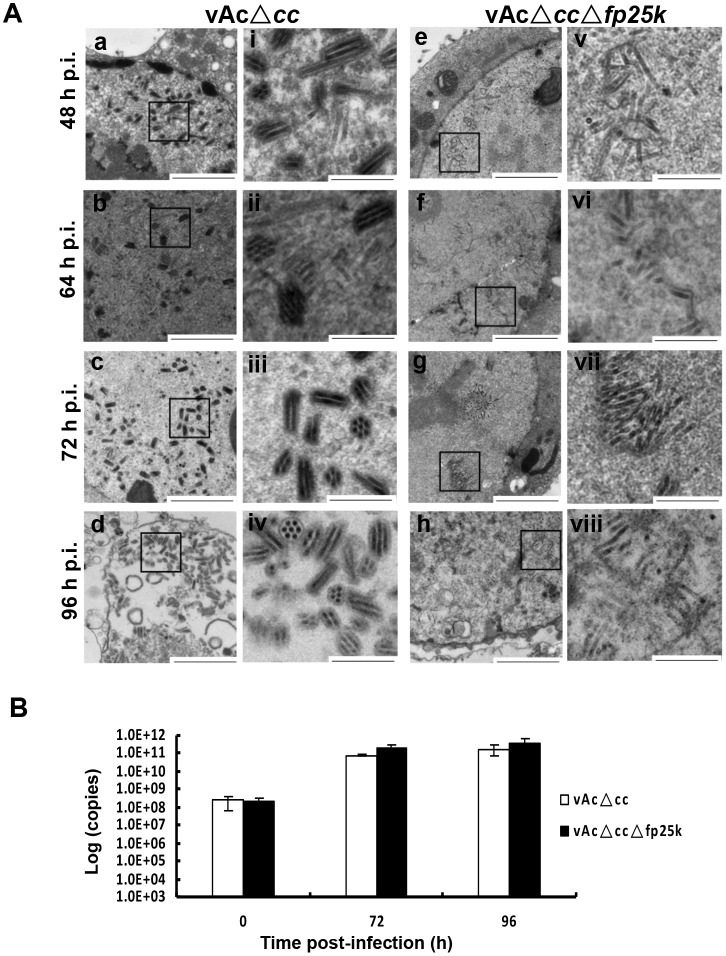
Cellular viral particles observation and determination.(A) Electron microscopy analysis. Sf9 cells were infected with vAcΔcc or vAcΔccΔfp25k at an MOI of 5. Infected cells were fixed with glutaraldehyde at 48, 64, 72 and 96 h p.i., and nucleocapsids occlusion was observed (i-viii). Enlargements of the blocked area in (a-h). Bars represent 1 μm and 250 nm. (B) Cellular viral particle determination. Sf9 cells were infected with vAcΔcc or vAcΔccΔfp25k (MOI = 5), total cellular DNA were collected at 0, 72 and 96 h p.i. and subjected to qPCR to determine the viral genome copy number. The data are from three independent experiments. Error bars represent standard deviation. Data were analyzed by two-tailed Student's t-test.